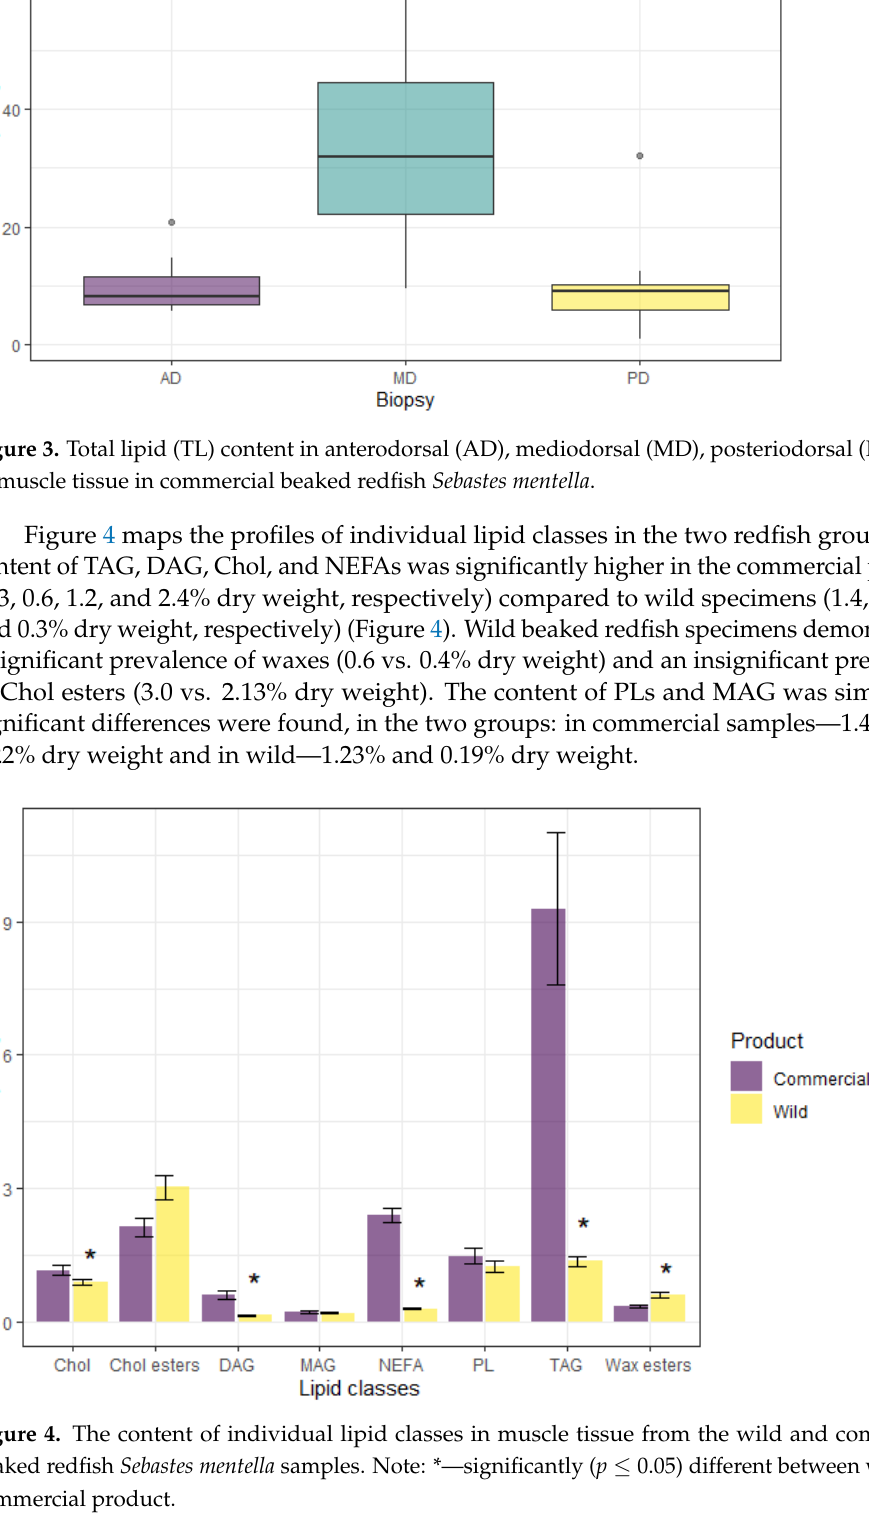
Figure 4. The content of individual lipid classes in muscle tissue from the wild and commercial beaked redfish Sebastes mentella samples. Note: *—significantly ( p ≤ 0.05) different between wild and commercial product. The analysis of lipid classes for different muscle regions in commercial redfish specimens revealed differences between the regions, mainly regarding TAG, Chol esters, and NEFAs (Figure 5). The MD biopsy region contained the highest amount of TAG compared to AD and PD. Application of the “random forest” machine learning algorithm confirmed that the MD region had a greater variation of the content of lipid classes as opposed to AD and PD—the test set predicted 100% of values for MD, while the predic- tion accuracy for AD and PD varied within 60–90%. The weightiest classifiers among li- pid classes (according to the mean decrease in Gini—MDG) are TAG (MDG = 4.10), as well as DAG (MDG = 3.24) and Chol (MDG = 3.15).